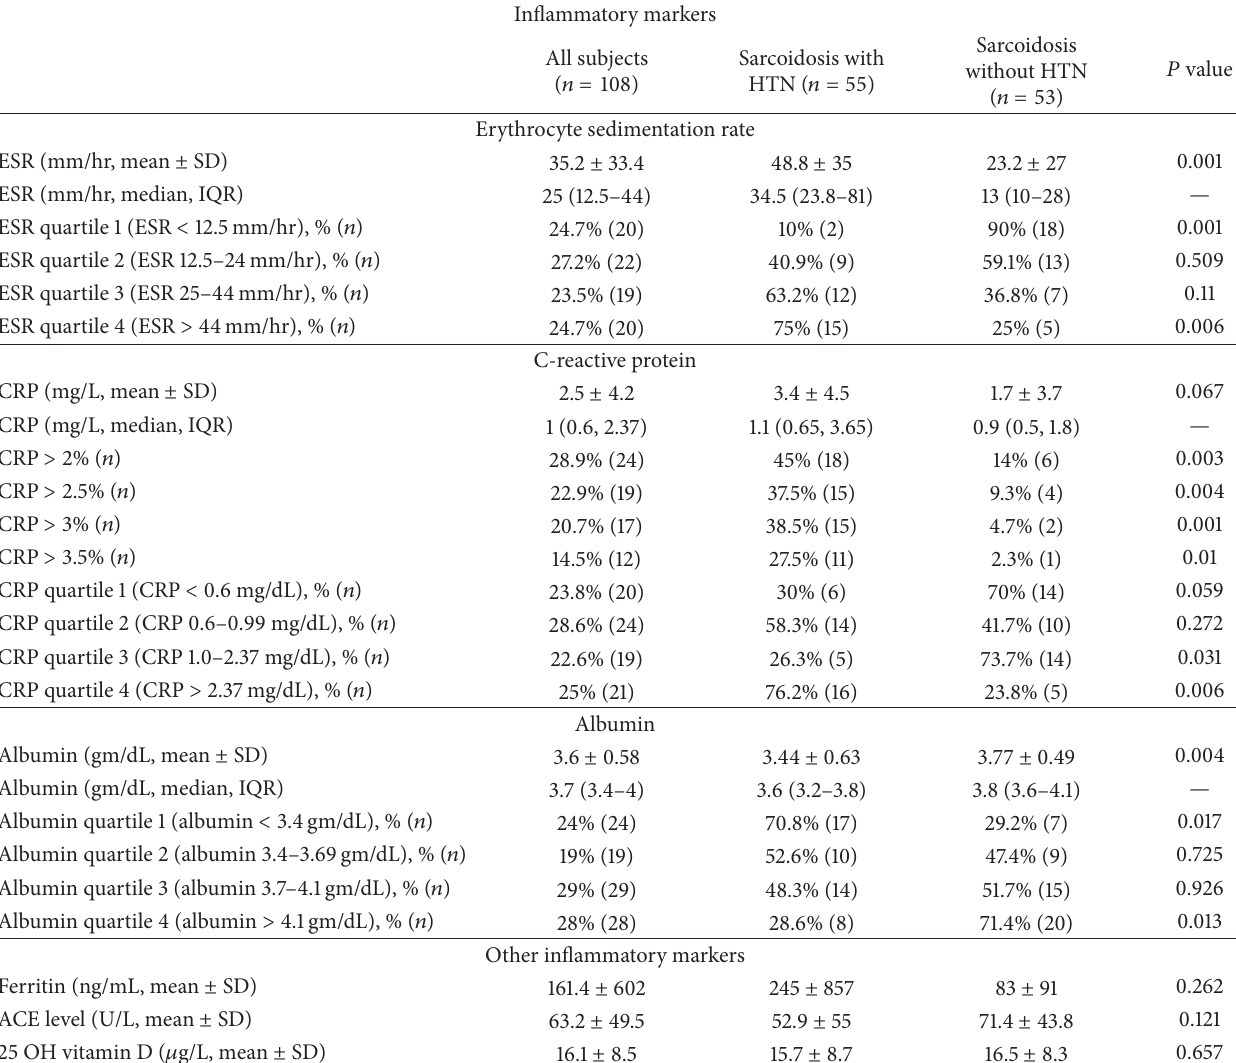
Table 2: Associations between various inflammatory markers with prevalence of systemic hypertension in sarcoidosis patients. Inflammatory